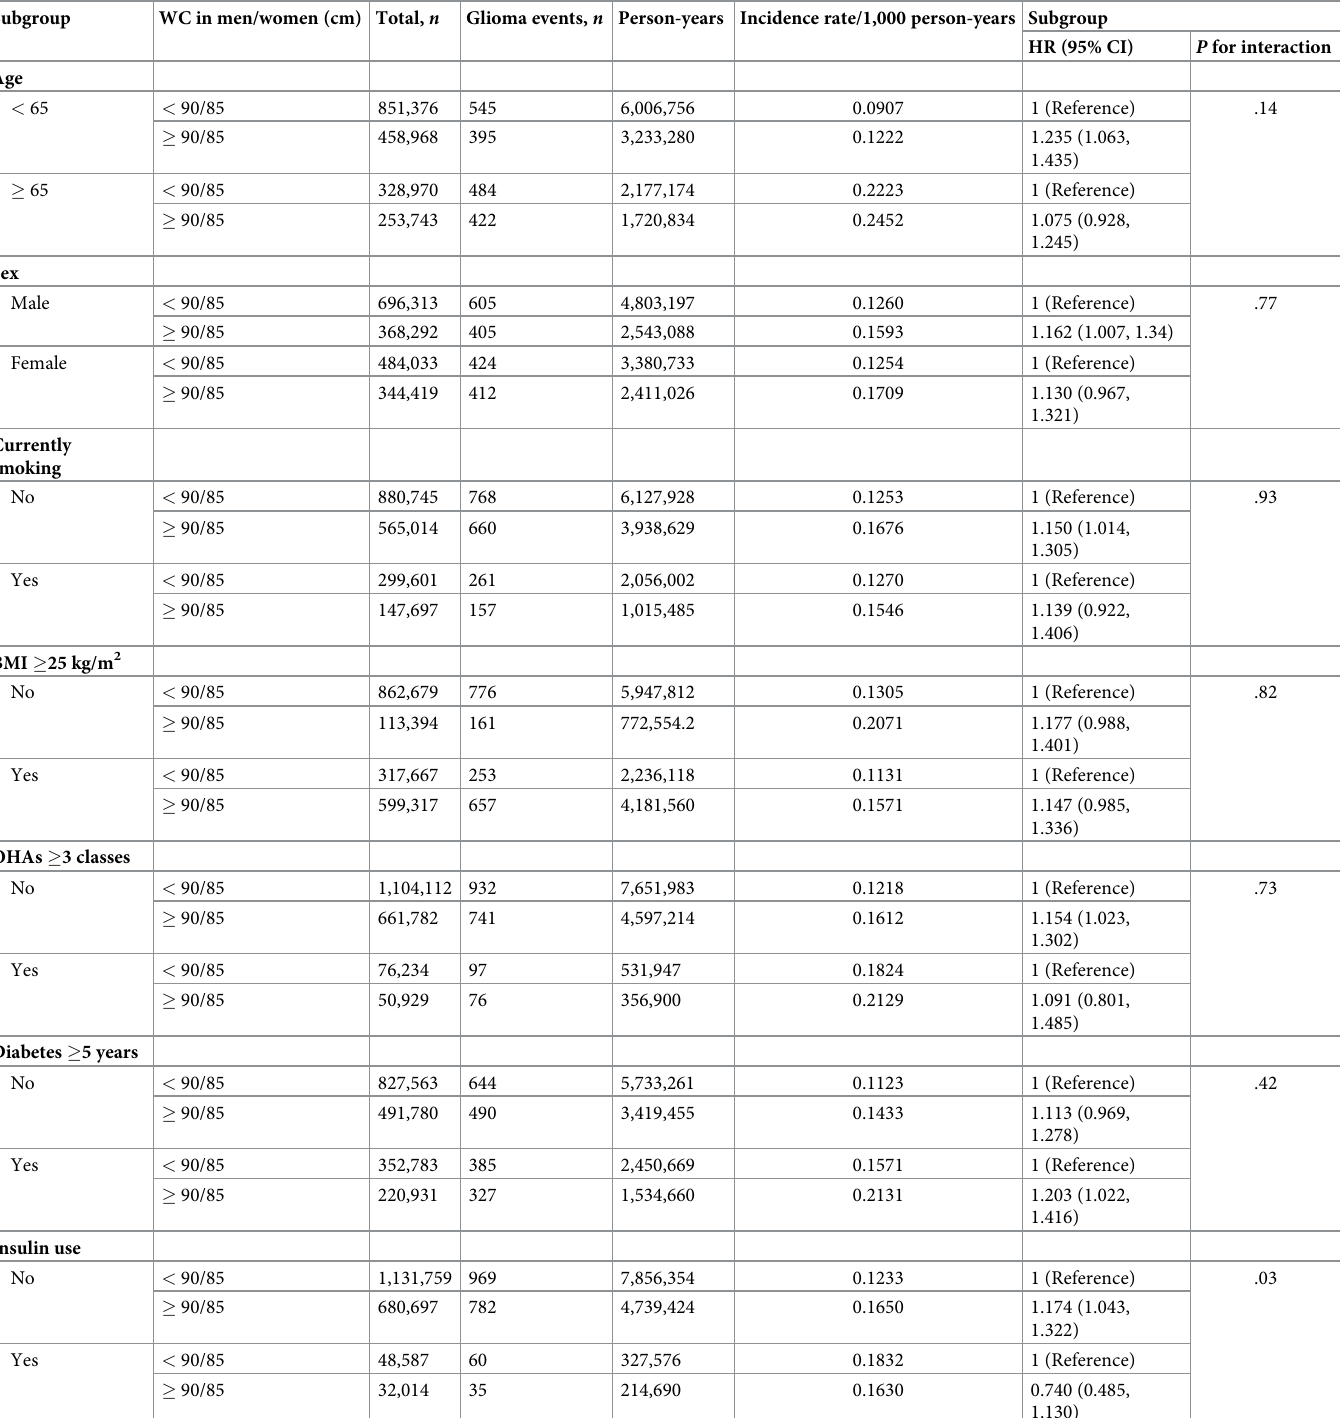
Table 3. Subgroup analyses of the association between waist circumference and glioma in diabetic patients.